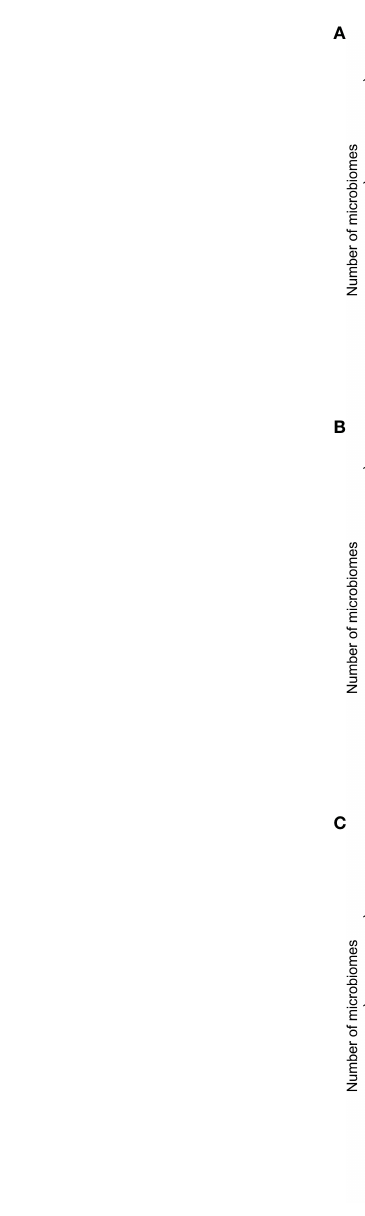
associated with speci fi c stool microbiome clusters at 10 days of life (Supplementary Figure S6). Stratifying infant stool microbiomes by maternal antibiotic administration during labour and delivery for